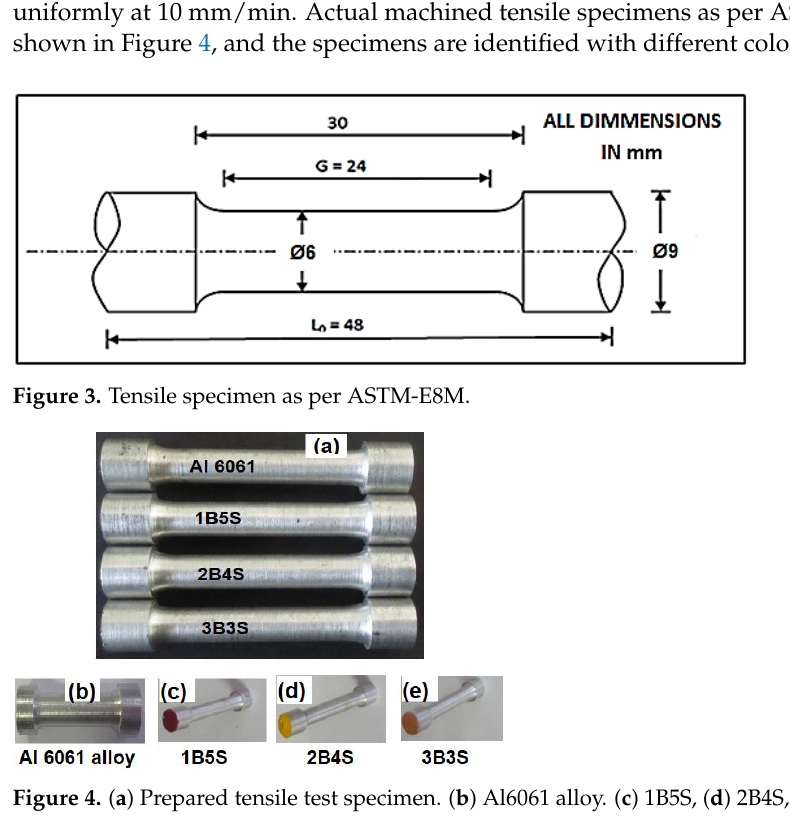
Table 3. Al6061 hybrid composites with different proportions of SiC and B 4 C reinforcements.